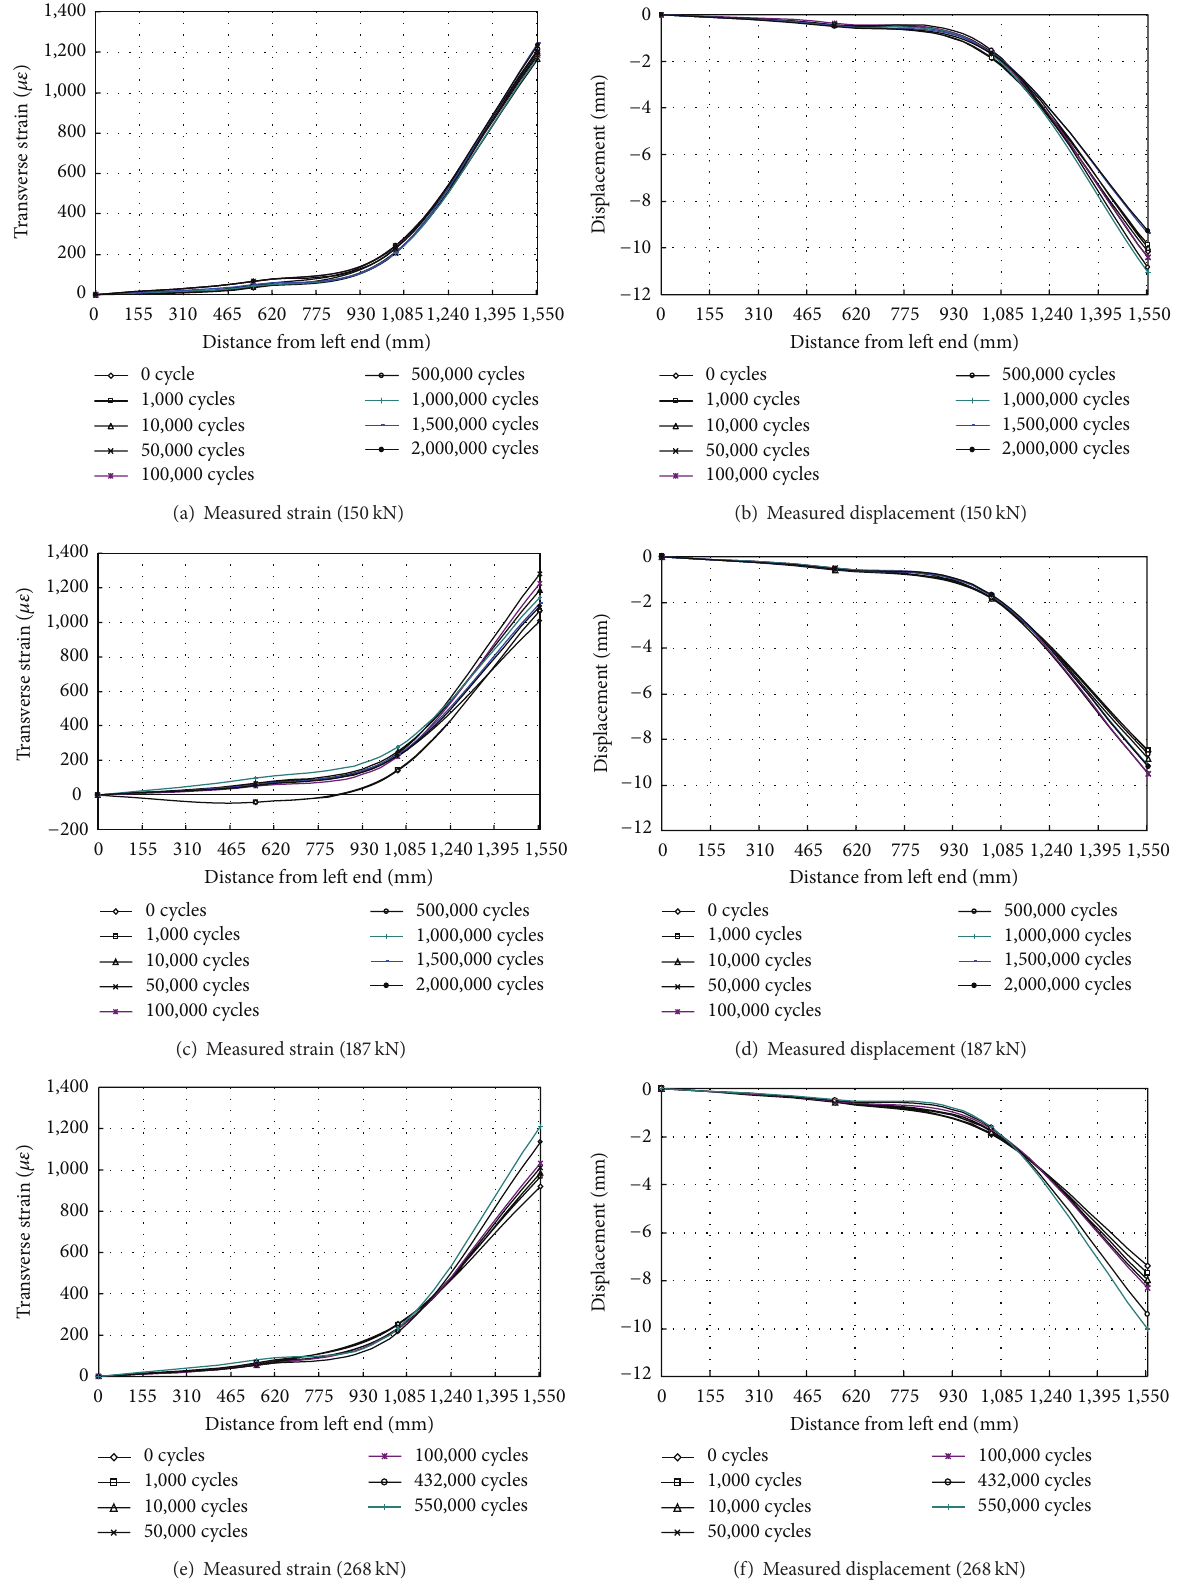
Figure 9: Load range-strain and displacement correlation at span length 2.5